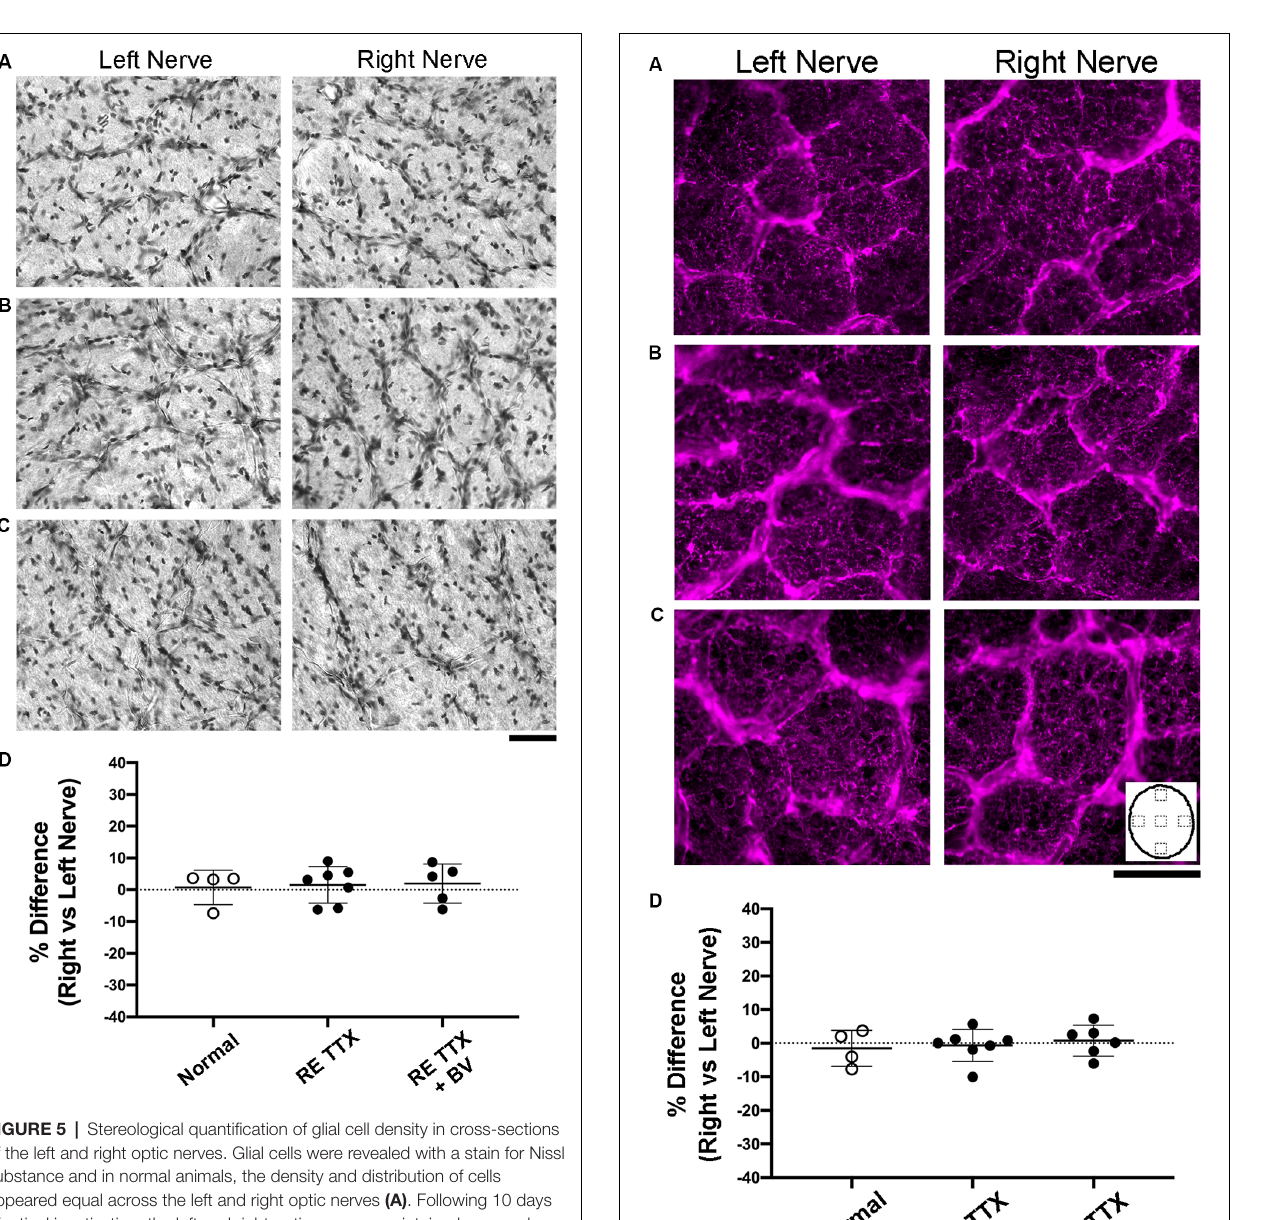
contrast gratings across a range of spatial frequencies ( Figure 7